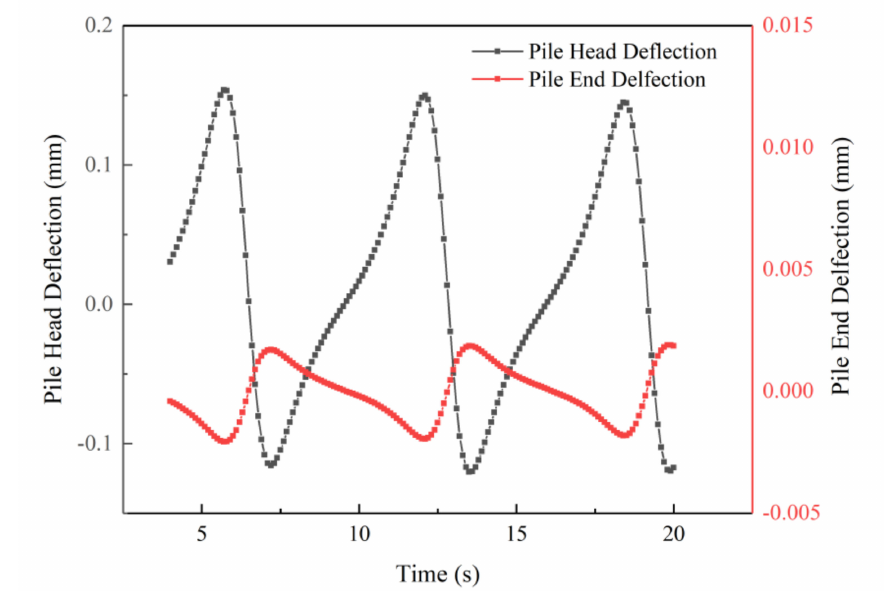
Figure 6. Time-domain response of the deflection of pile head and pile end.